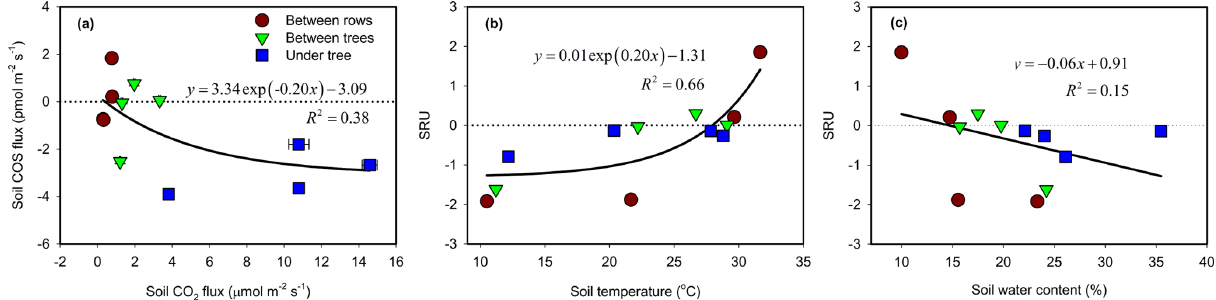
Figure 6. The relationships between soil COS and CO 2 flux rates (chamber measurements a ). The response of soil relative uptake (SRU; normalized ratio of COS to CO 2 fluxes) to soil temperature (b) and to soil water content (c) . The data points represent the diurnal average ( N = 24) of each site and season (measurement campaign). Error bars represent ± 1 SE around the mean (often the size of the